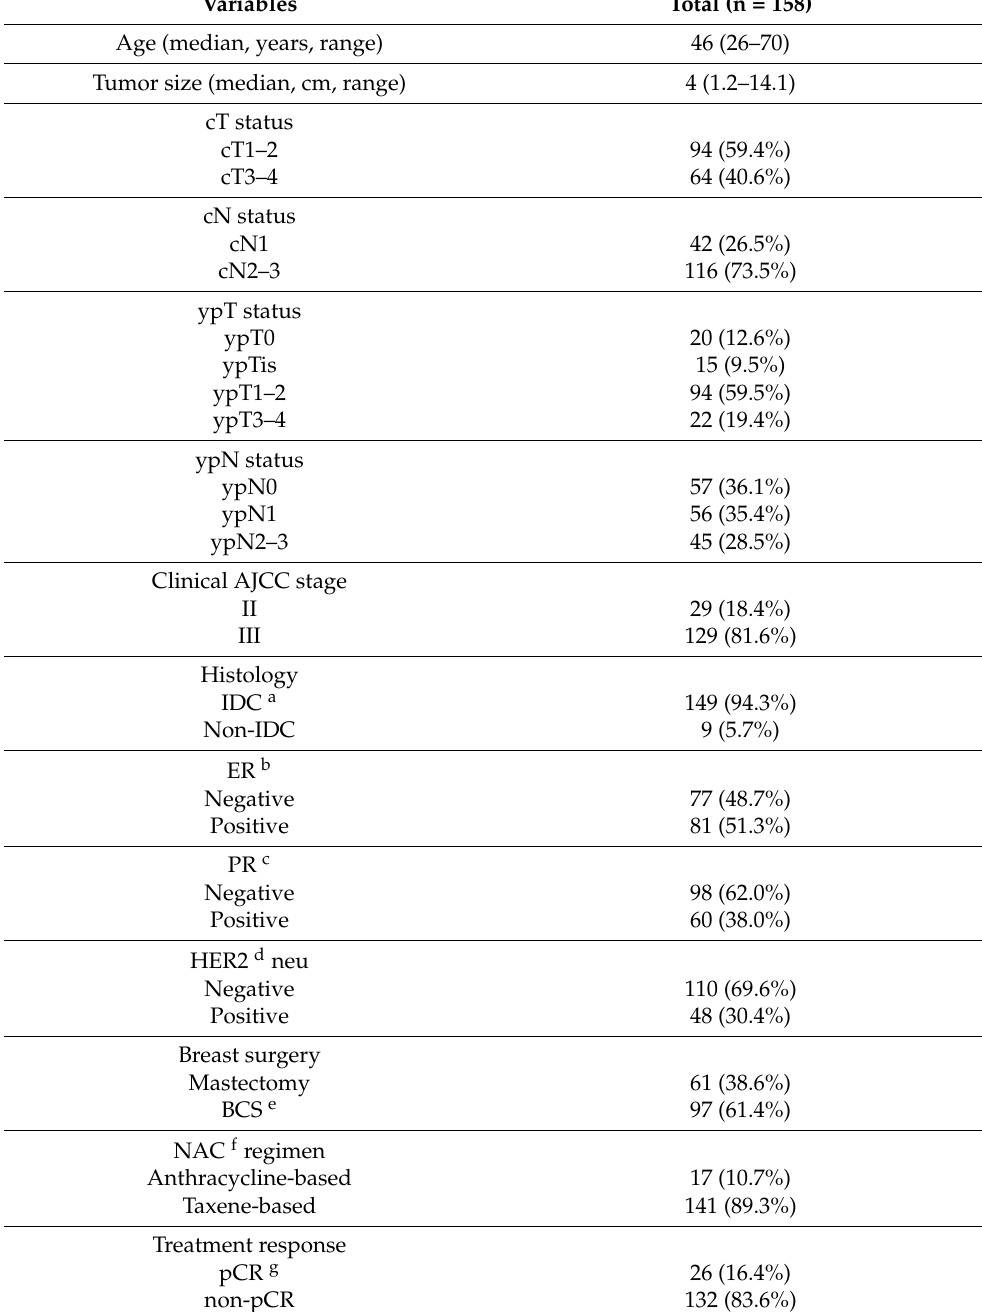
Table 1. Clinicopathologic